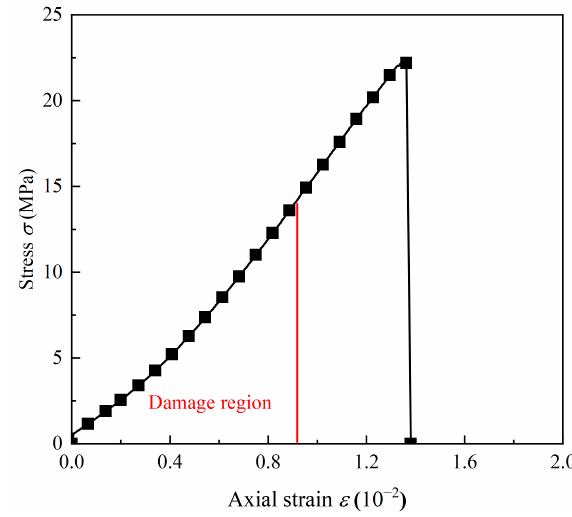
Figure 10. Characterization of the damage region. Table 2. Axial stress and the corresponding accumulated damage factor.